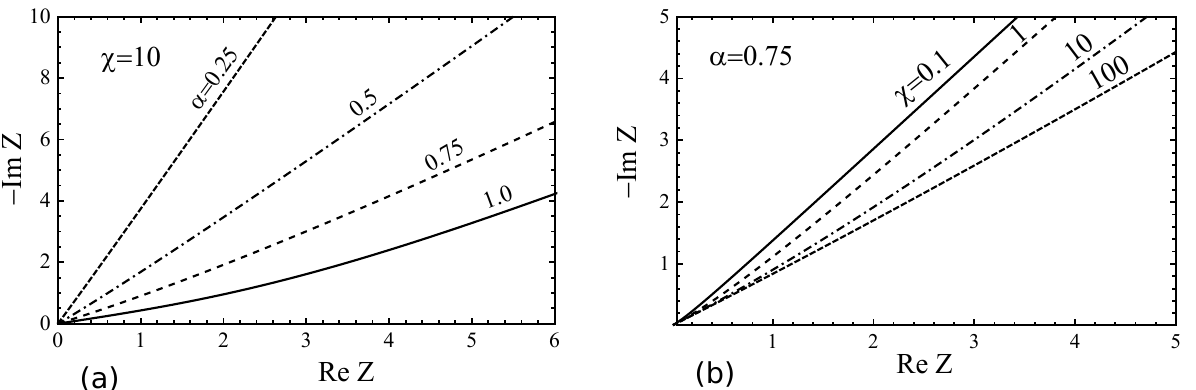
Figure 2. Nyquist plots corresponding to the fractional (0 < α = β ≤ 1) phase-field subdiffusion for different values of α ( a ) and χ ( b ).